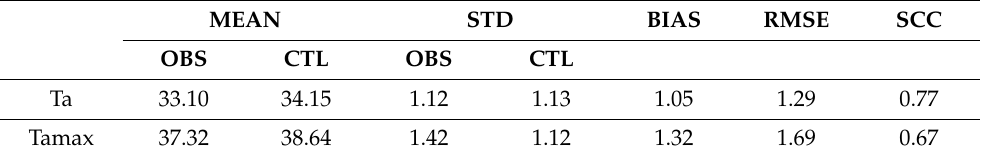
Figure 5. ( a ) Daily averaged observed maximal air temperature, ( b ) simulated maximal air temperature, and ( c ) their difference (unit: °C) over the research period in EC. Table 2. Statistical values of observed and simulated 5-day mean Ta and Tamax in study region, ◦ C. MEAN STD BIAS RMSE SCC OBS CTL OBS